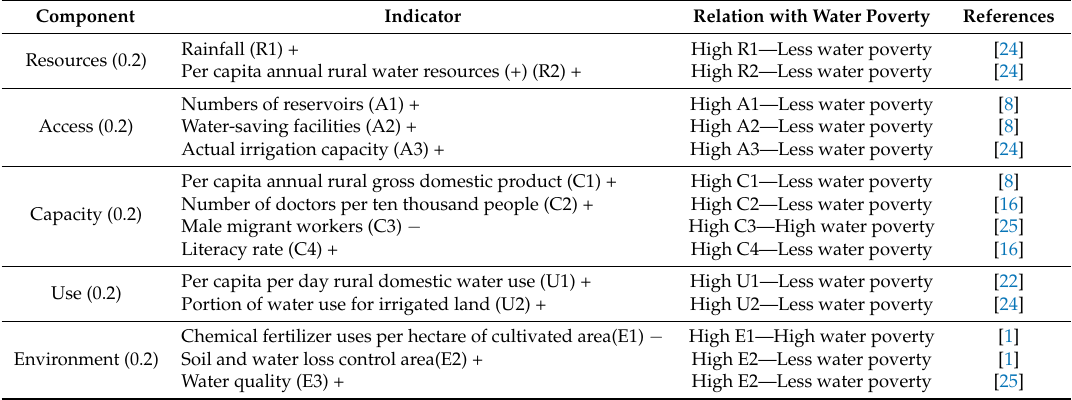
Table 1. Details of the WPI (Water Poverty Index) components, indicators, and